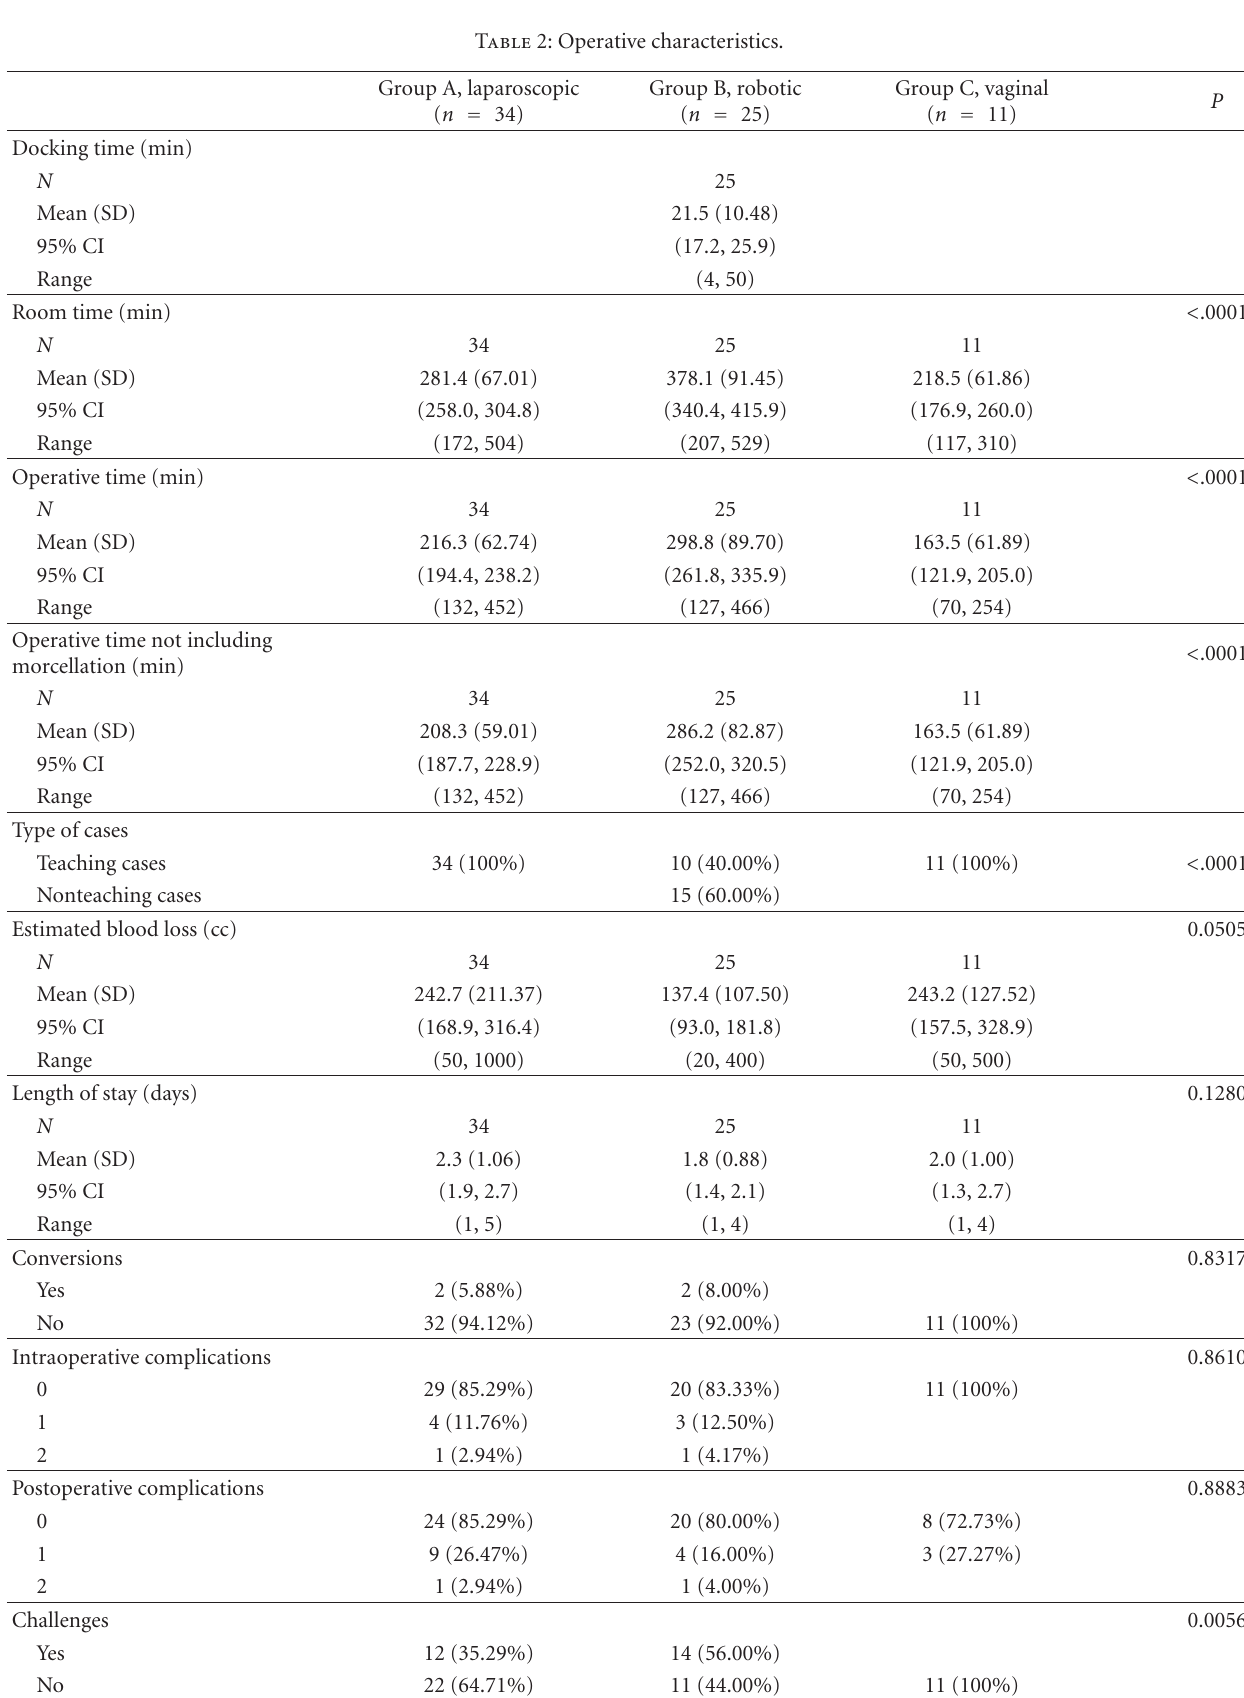
Table 2: Operative